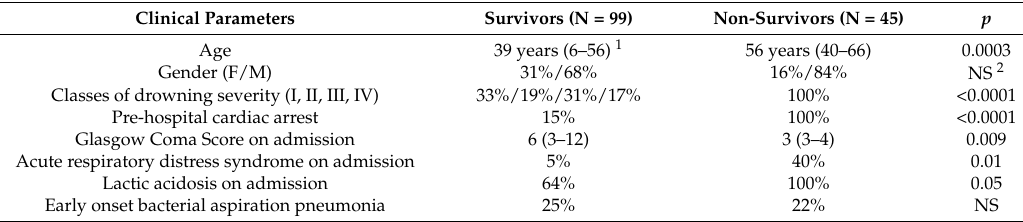
Table 2. Characteristics of the near-drowning patients according to their final outcome (N =